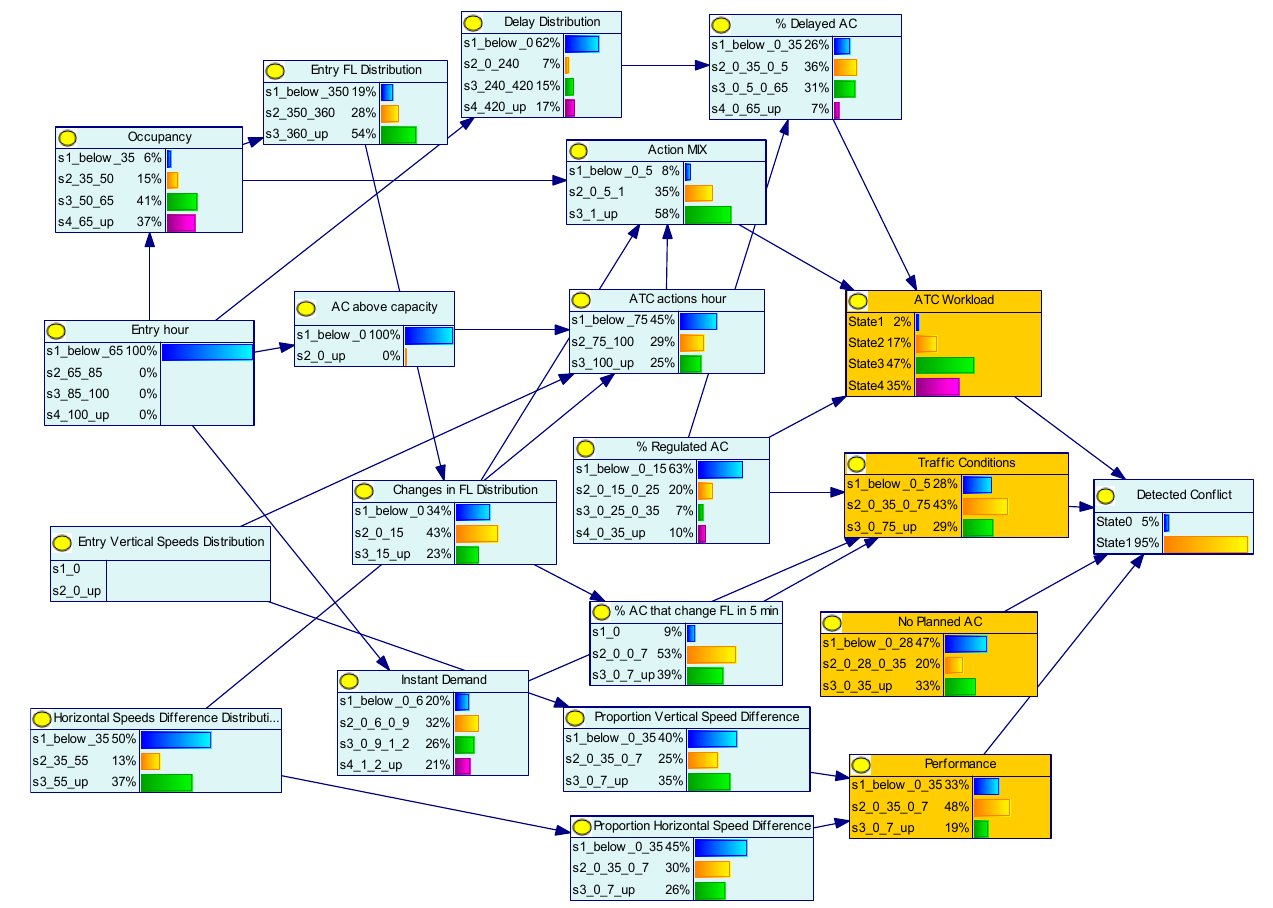
Figure 6. Forward analysis LECMSAN below 20% of its capacity .